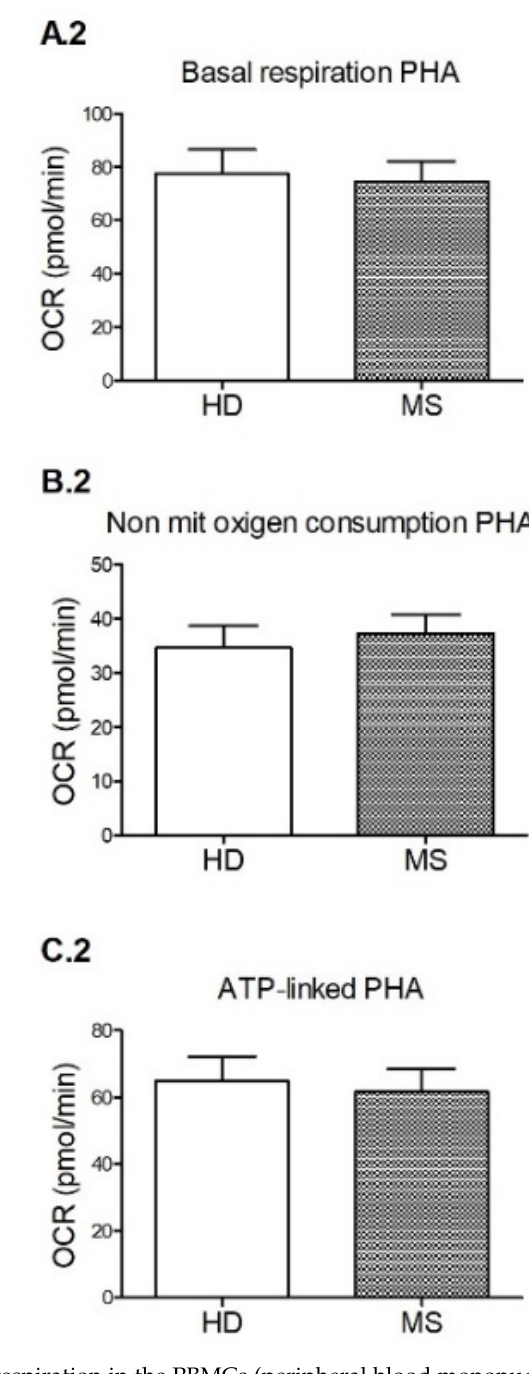
Figure 3. Impaired mitochondrial respiration in the PBMCs (peripheral blood mononuclear cells) from healthy donors (HD) vs. multiple sclerosis (MS) patients. Indexes of mitochondrial respiratory function were calculated from the OCR profile of non-stimulated ( 1 ) and PHA-stimulated ( 2 ) PBMCs: basal respiration ( A ), non-mitochondrial oxygen consumption ( B ), and ATP-linked ( C ). Healthy donors (HD) n = 17; Multiple sclerosis patients (MS) n = 18. OCR: oxygen consumption rate; PHA = phytohemagglutinin. Data were expressed as mean ± s.e.m. Comparisons were evaluated with the non-parametric test U